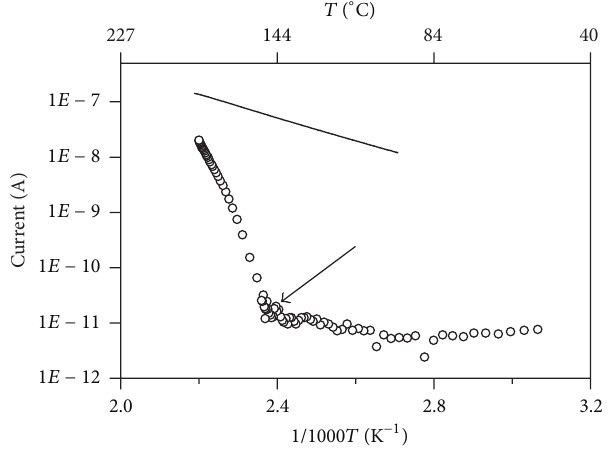
Figure 11: The Arrhenius plot of MoO 3 microsensor, warming up and (open circles) and cooling down (continuous